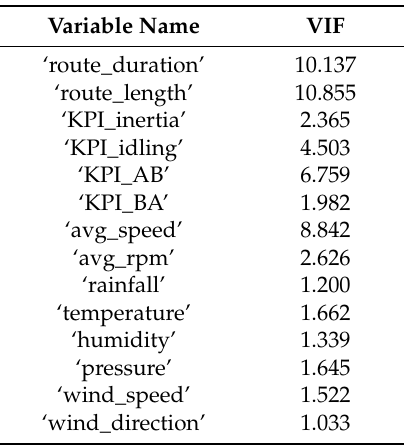
Table 3. VIF for the predictor variables.